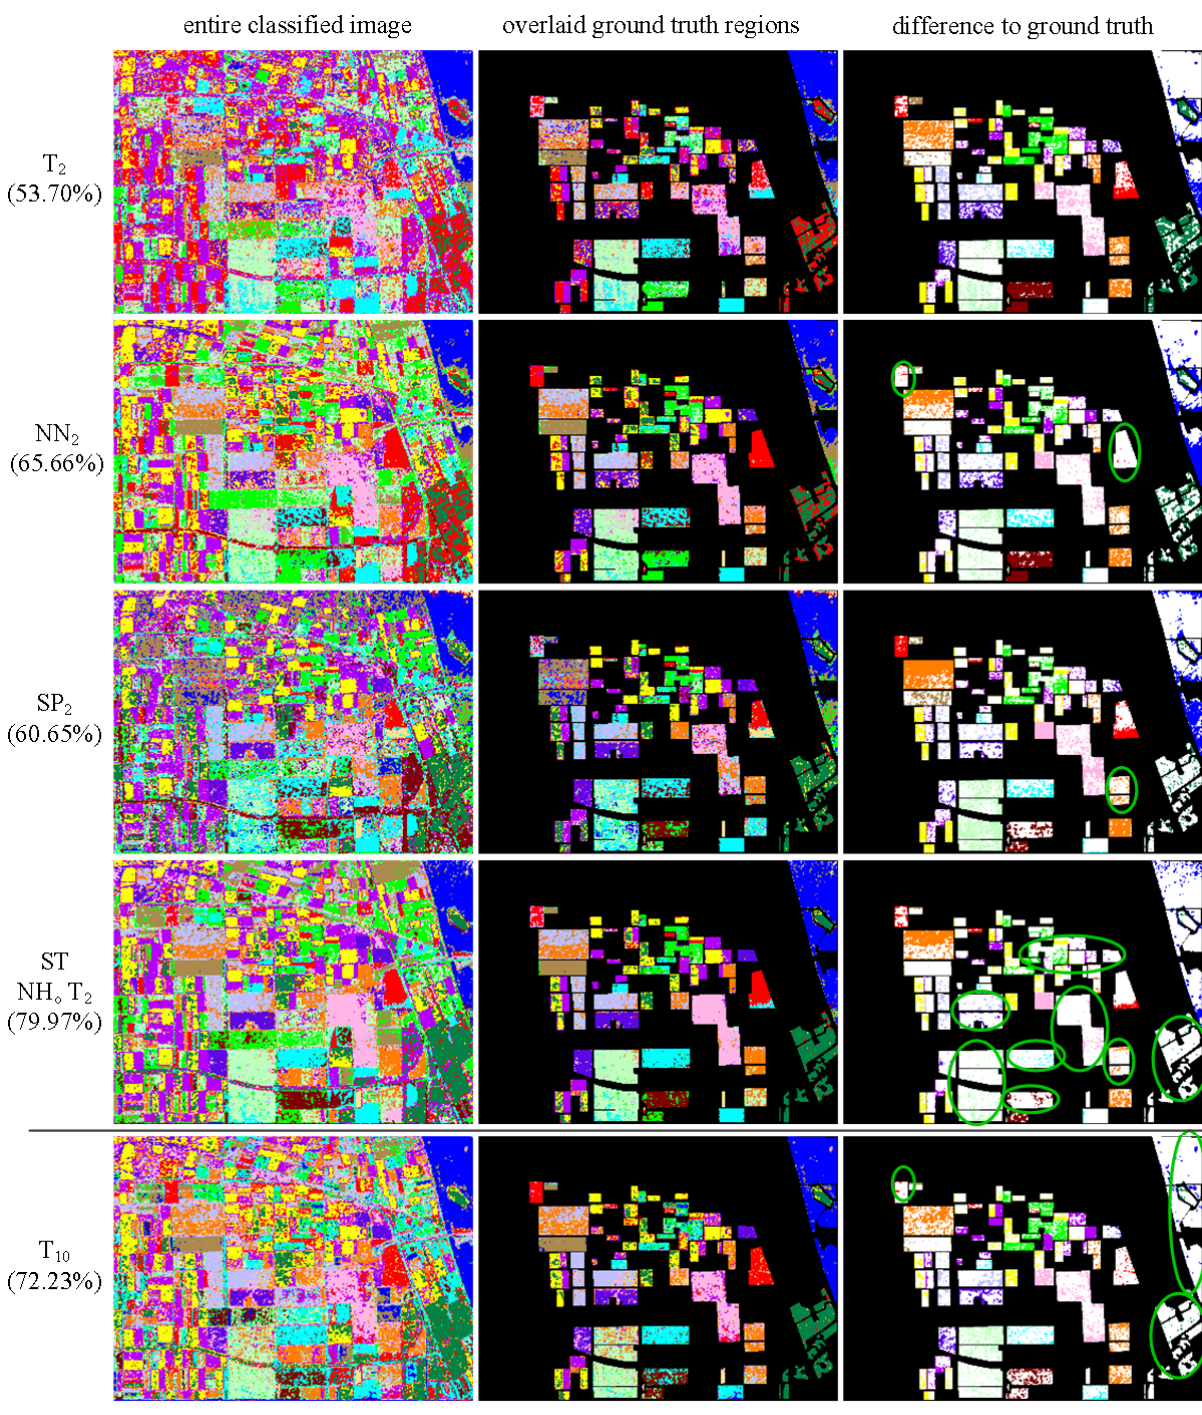
Figure 17. Differences of distinct SSL approaches using unsupervised + supervised methods (NN, SP) and bagging ensemble self-training (using Random Forest) over a T instance. White color indicates a match between classification results and ground truth. The green circles mark best classification performance achieved in a particular area over all classification maps. Percentages are the respective classification